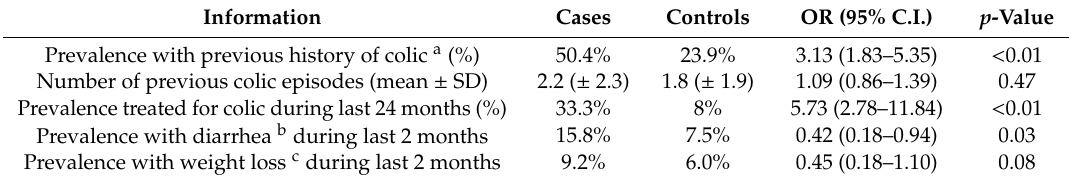
Table 3. Results of questionnaire data: owner-reported previous medical history of cases and controls as outlined in a questionnaire presented after agreement of study participation. The p -value for statistical significance was corrected for the number of analyses (n = 5) according to Bonferroni, i.e., p < 0.01 (0.05 /